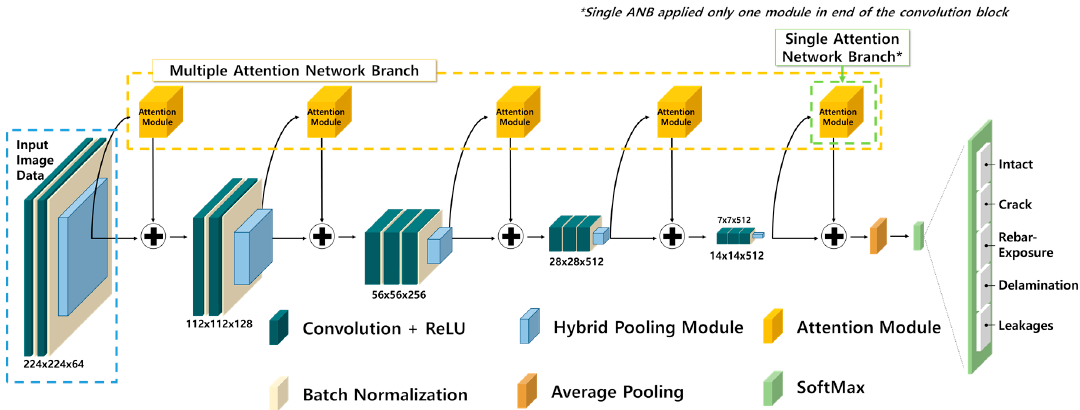
Figure 1. Convolution-based multi-damage recognition neural network for concrete structures.